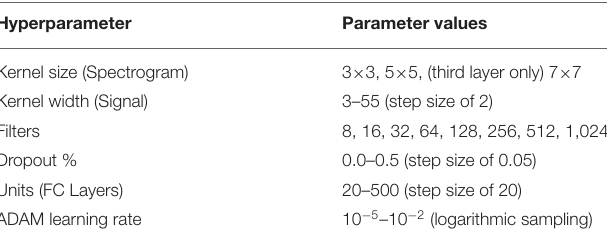
TABLE 2 | The hyperparameters tuned during optimization, with the range of possible values used by the Random Search algorithm.